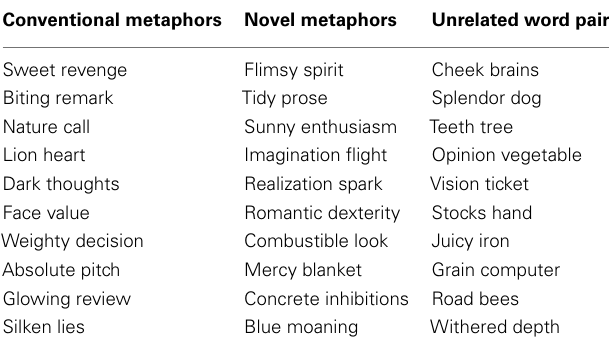
TableA1 | Examples of conventional metaphors, novel metaphors, and unrelated